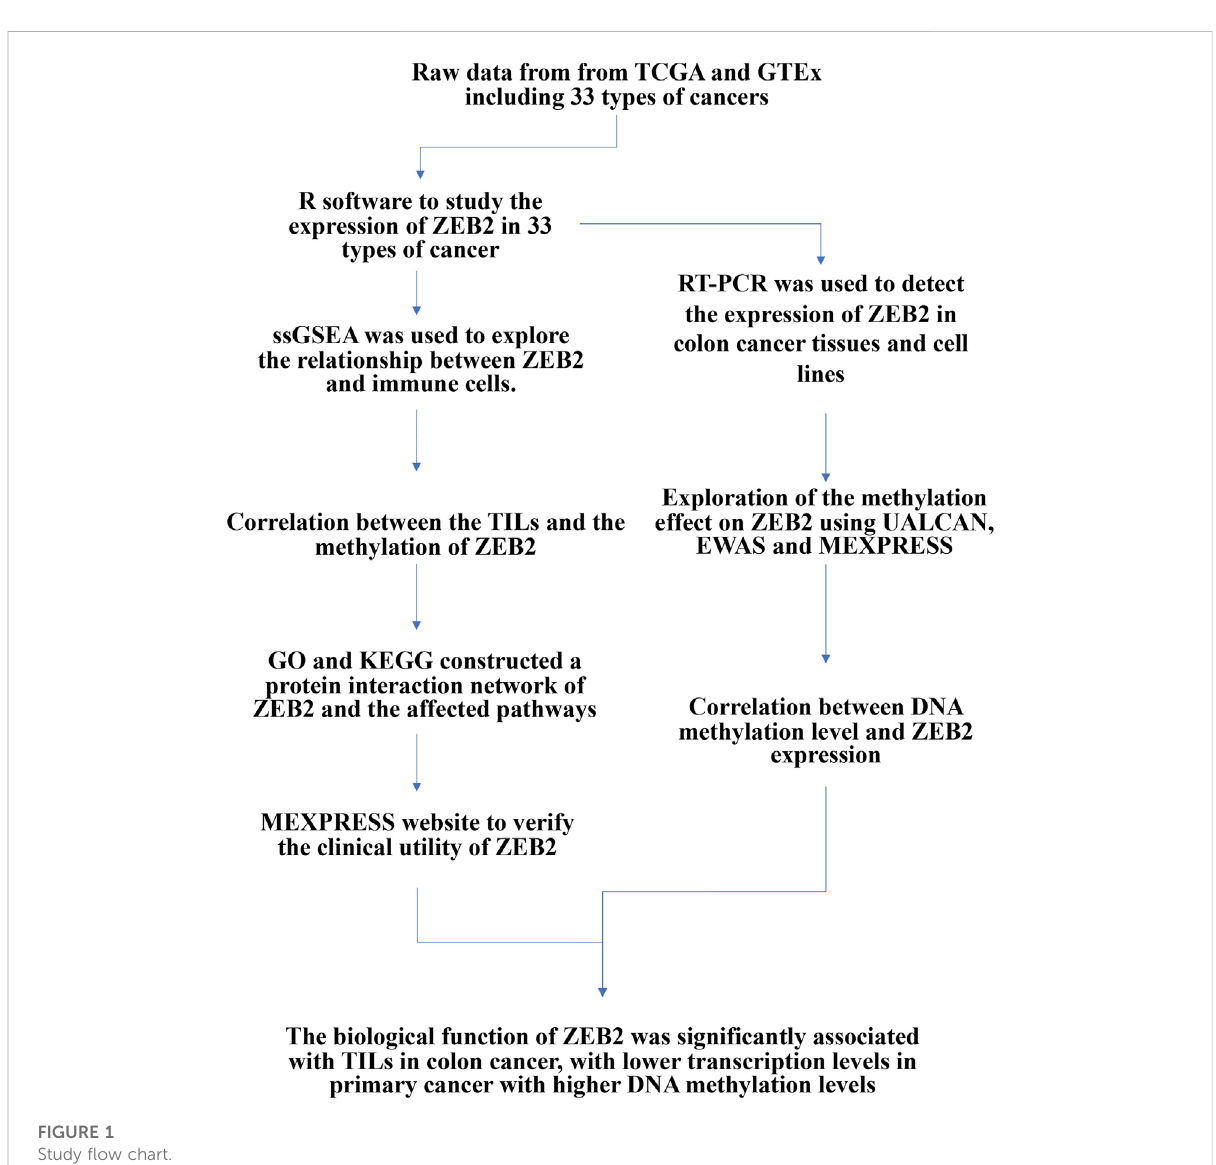
FIGURE 1 Study fl ow